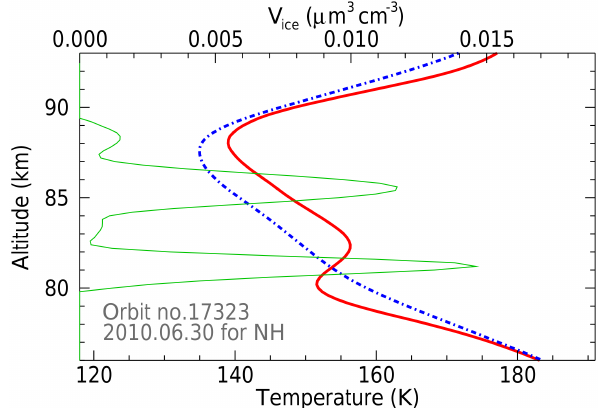
Figure 8. A typical example for demonstrating the temperature en- hancement in the event during orbit no. 17323 in the NH on 30 June 2010. The real temperature profile is shown as the red curve, while the zonal mean temperature profile averaged by all profiles during one day is shown as a blue dash-dot curve. Green curve represent the V ice profile for this